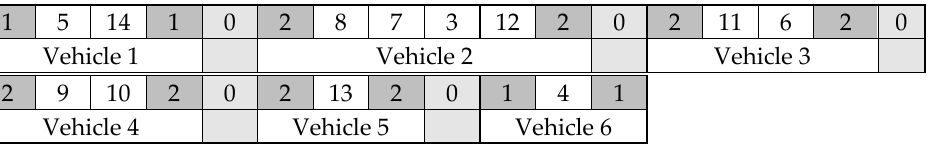
Figure 3. Solution representation for chromosome-1.